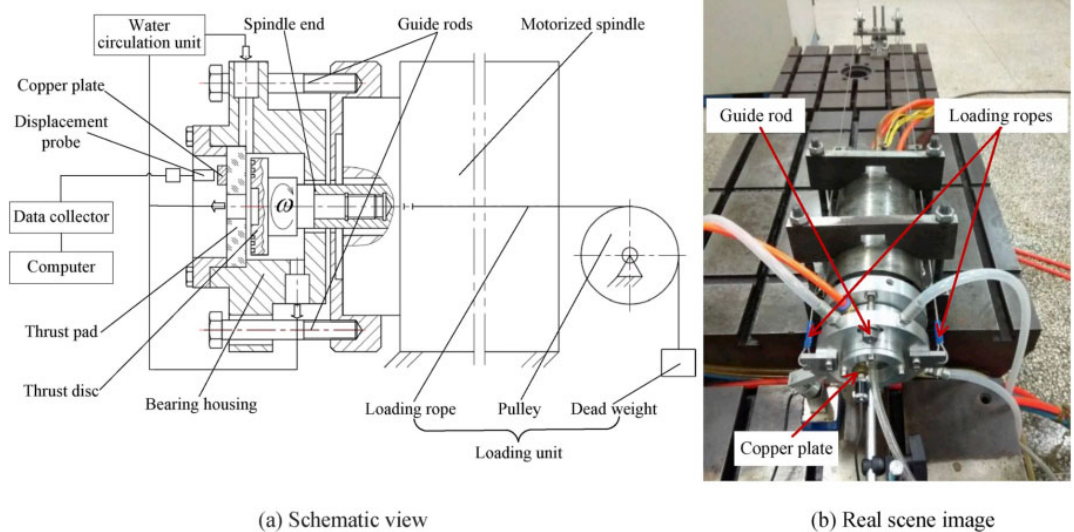
Fig. 24 Experiment setup to measure the characteristics of the spiral-groove thrust bearing (SGTB) [252]. Reproduced with permission from Ref. [252], © Elsevier Ltd.,